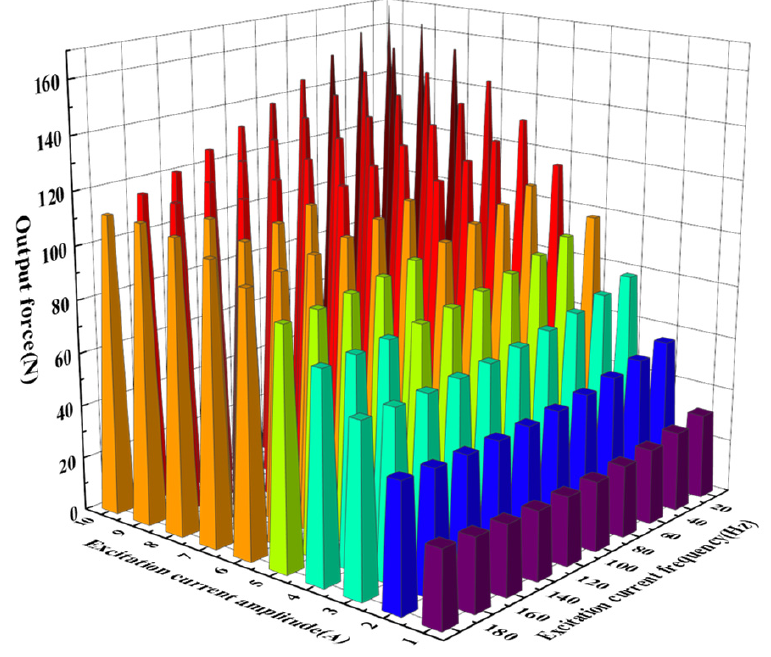
Figure 6. Electromagnetic force at different current amplitude and frequency.